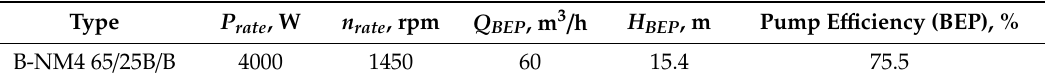
Table 1. Published characteristics of pump from manufacturer.